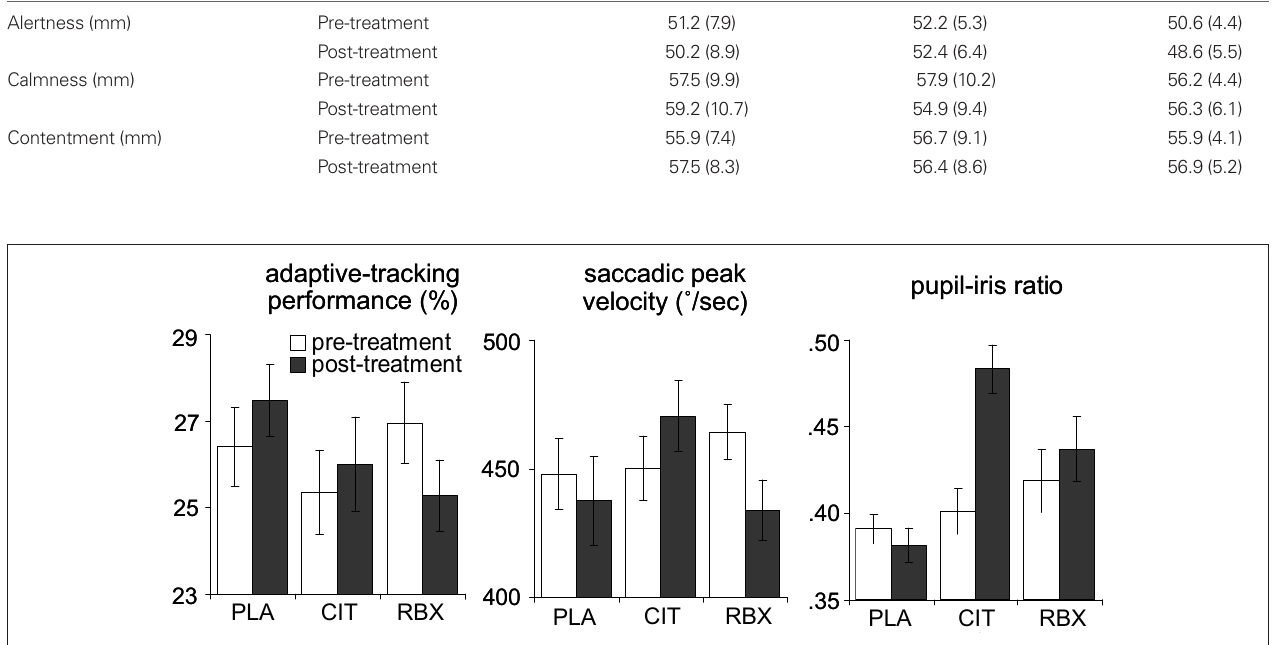
Figure 3 | Adaptive-tracking performance, saccadic peak velocity and pupil–iris ratio pre-treatment and post-treatment, separately for each treatment group (error bars indicate standard errors of the mean). PLA, placebo; CIT, citalopram; RBX,